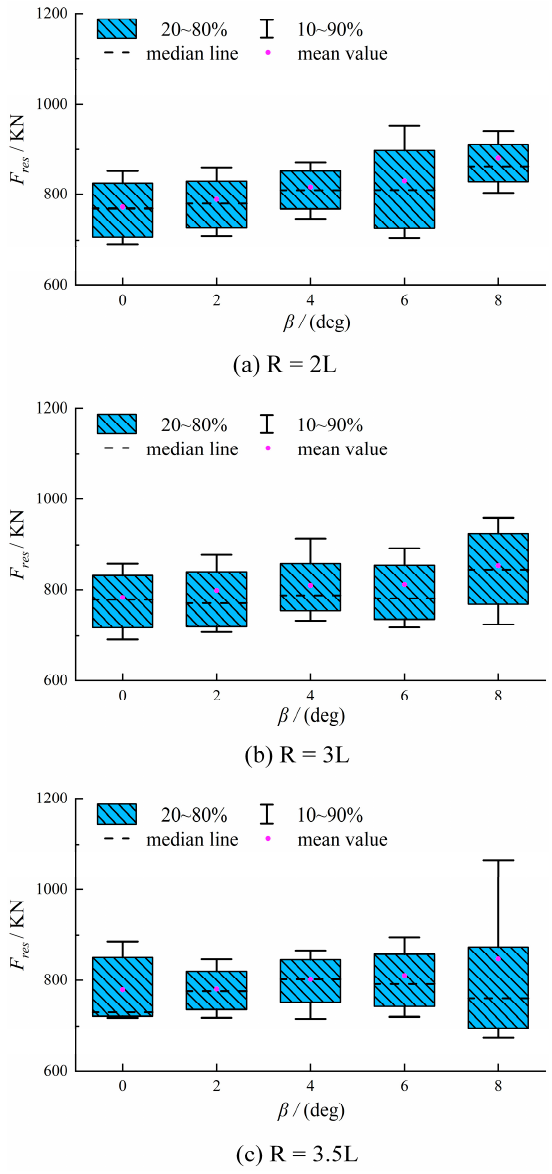
Figure 17. Box plot of Fres under different drift angles.